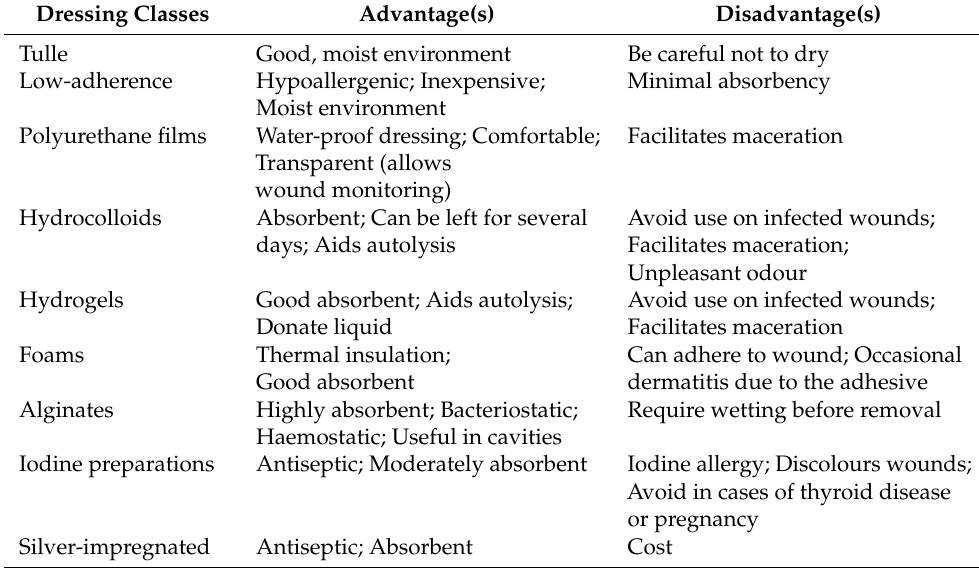
Table 2. Classes of dressings used in DFUs. Adapted from Hilton et al. [85] and Kavitha et al.